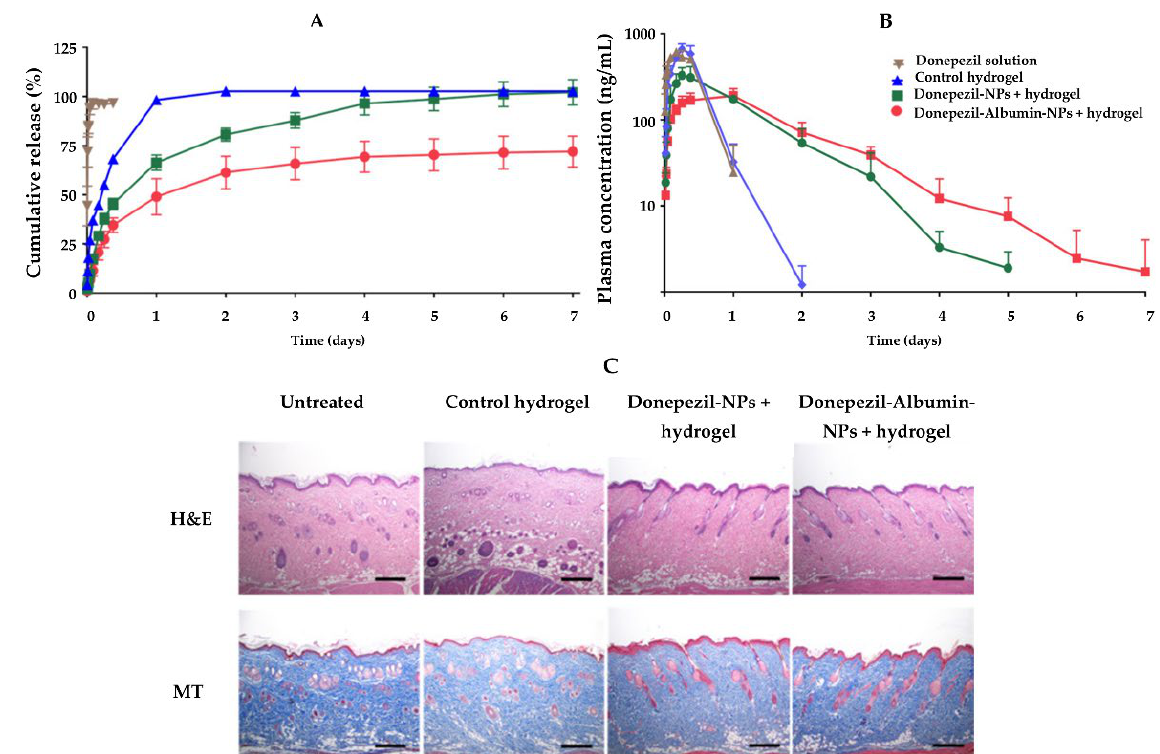
Figure 9. ( A ) In vitro release pattern of donepezil, ( B ) plasma concentration pattern over time, after in vivo administration of donepezil, and ( C ) skin histology 7 days after in vivo administration. The staining was performed with hematoxylin and eosin (H&E) and Masson’s trichrome (MT). Scale bar: 400 µm. Adapted with permission from [107], copyright © 2021 MDPI.